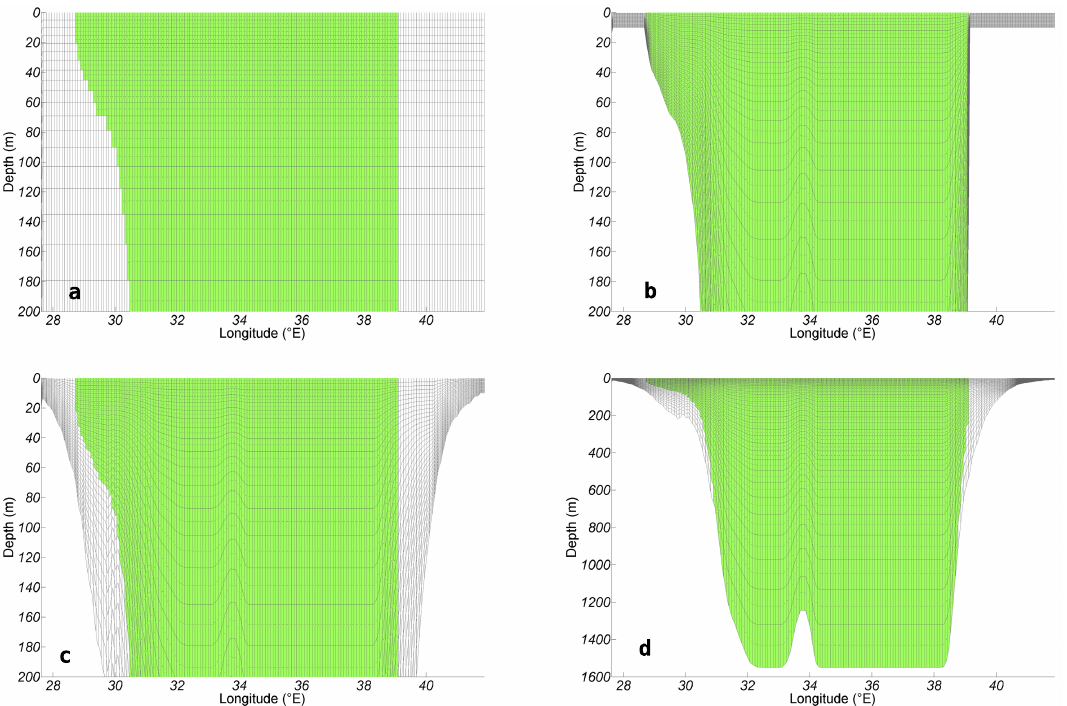
Fig. 2. Standard NEMO vertical grids shown at a Black Sea transect along 44 ◦ N. Green areas represent wet points included in computations; white areas represent masked-out dry points. Dots show location of T-points within the cells. There is an extensive shelf on the western side of the transect and a very narrow shelf on the eastern part, which is not resolved by the model. (a) z coordinate grid (ZCO); (b) s coordiante grid (SCO). The undulation of the numerical levels is due to the underwater ridge which is shallower than 1550m; (c) s coordiante grid with enveloping topography (Z*SIG). For clarity, only the upper parts of the grids are shown in subfigures (a) – (c) . The Z*SIG grid for the full depth of sea is shown in subfigure (d)